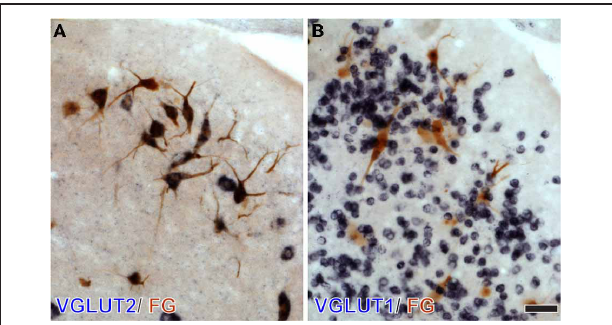
FIGURE 4 | DCN neurons projecting to the IC express VGLUT2 but not VGLUT1. After an injection of Fluorogold (FG) into the IC, large DCN neurons, presumably fusiform and giant cells, show immunoreactivity for FG (brown). Their cell bodies are positive for VGLUT2 mRNA (dark blue in A ), and negative for VGLUT1 mRNA (B) Note that numerous granule cells express VGLUT1 only. Bar: 40 μ m.